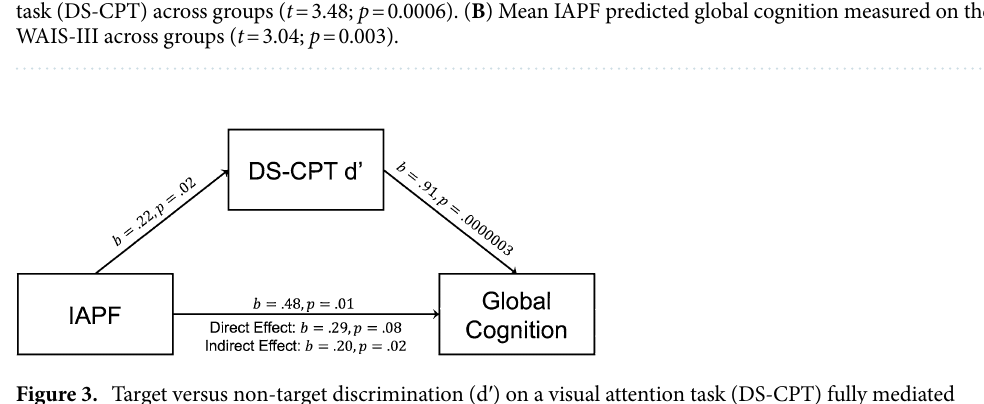
Figure 3. Target versus non-target discrimination (d ′ ) on a visual attention task (DS-CPT) fully mediated the relationship between IAPF and global cognition across groups (Average Causal Mediation Effect (ACME) b = 0.20; 95% Confidence Interval 0.03–0.40; p =